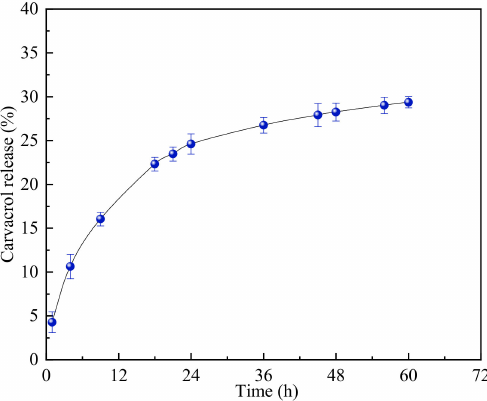
Figure 8. The release of CA from zein/SC/CA nanoparticles soluble in water at 25 ◦ C and pH 7.